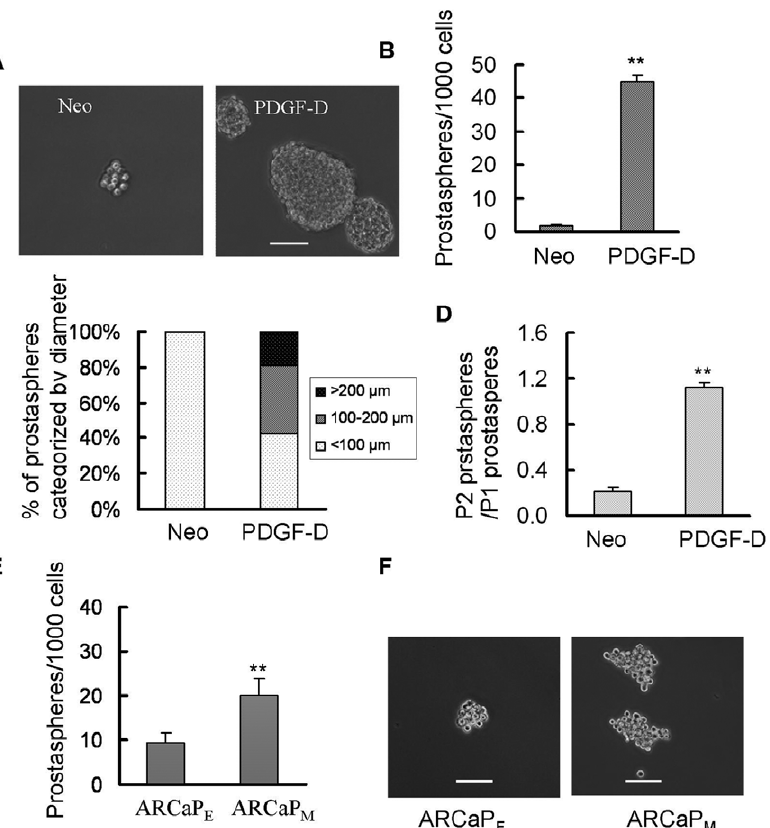
Figure 2. Prostaspheres were increased in cells having EMT phenotype. (A) Prostaspheres from PC3 Neo and PC3 PDGF-D cells were photographed and shown (bar, 100 m m). (B) The numbers of prostaspheres were counted under microscope. (C) Prostaspheres were photographed and the size of prostaspheres in diameter was measured using software image analysis program Scion Image. (D) The prostaspheres (P1) were collected and re-plated at a density of one cell per well in 96-well plate with ultra low attachment. After 12 days of incubation, the numbers of prostaspheres (P2) were counted under a phase contrast microscope. (E) The numbers of prostaspheres from ARCaP E and ARCaP M cells were counted under microscope. (F) Prostaspheres from ARCaP E and ARCaP M cells were photographed and shown (bar, 100 m m). **, p , 0.01 compared to Neo or ARCaP E cells (Neo: PC3 Neo cells, PDGF-D: PC3 PDGF-D cells).